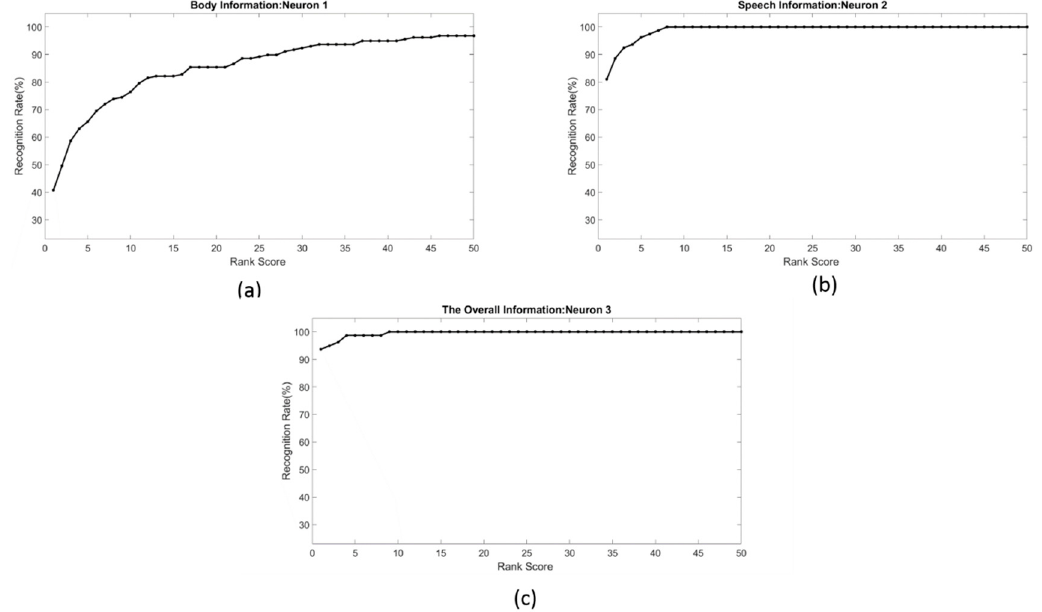
Figure 14. ( a ) CMC based on body information calculated on Backward group from the RGB-D database, ( b ) CMC based on speech information calculated on selected utterances from the TIDIGTS database, and ( c ) CMC based on temporal binding of speech and body information where body information is evaluated as described in Figure 14a and speech information is evaluated as described in Figure 14b.